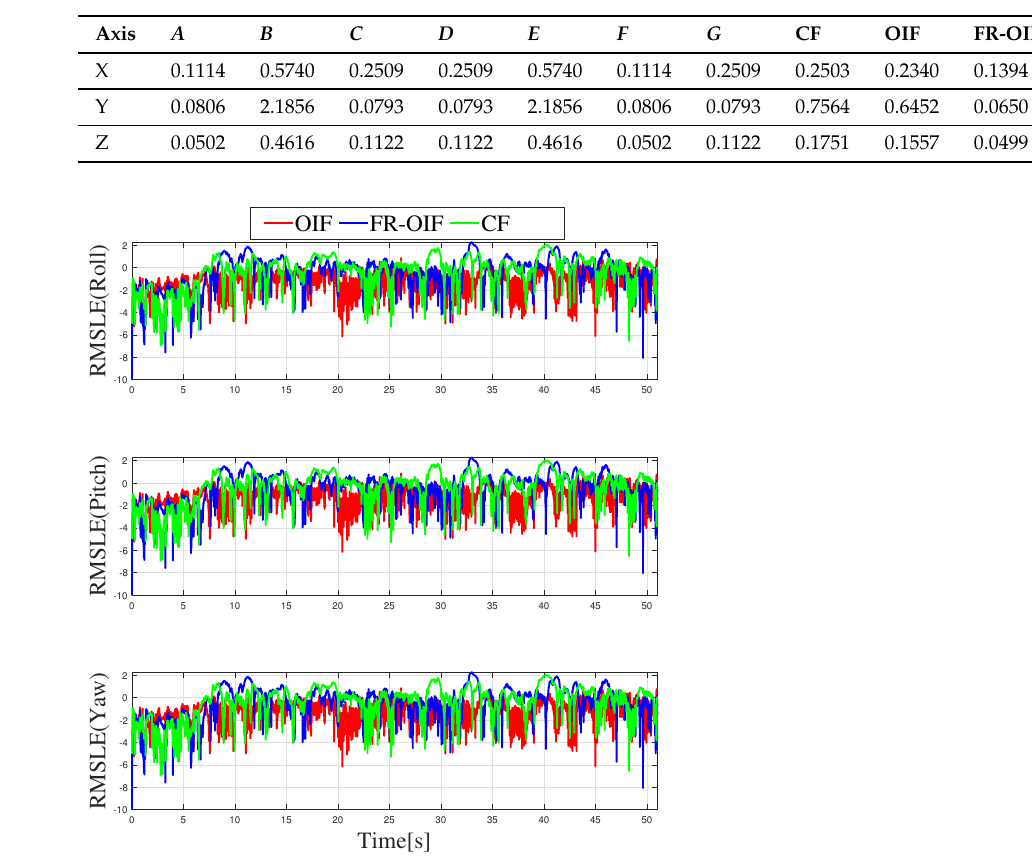
Figure 13. Semi-logarithmic root mean square error for orientation represented in Euler angles, obtained from different fusion (CF, OIF,